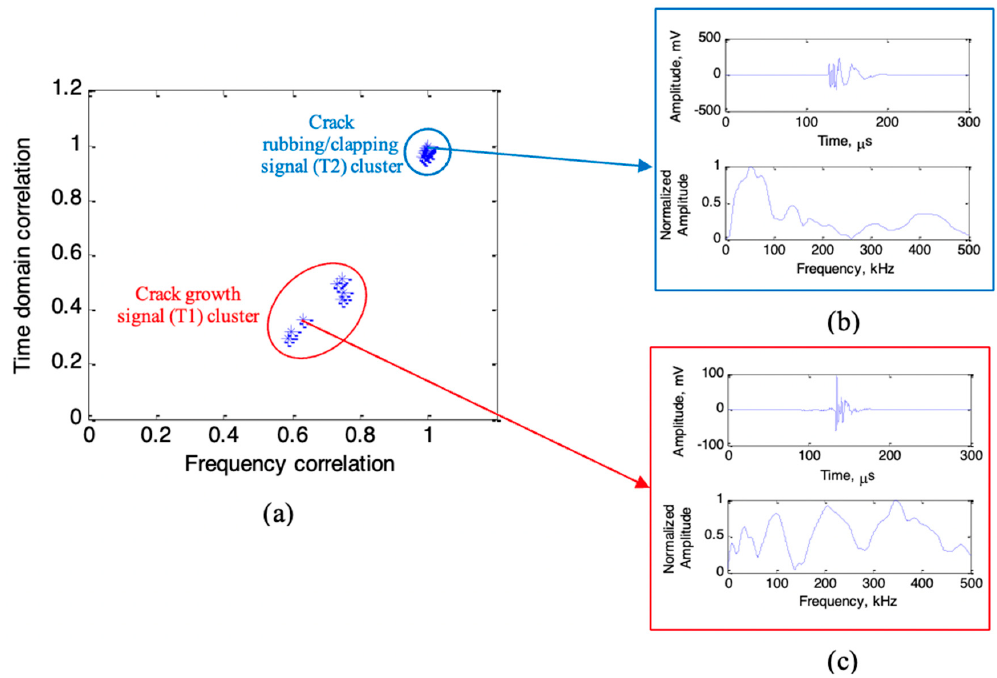
Figure 21. Clustering of fatigue crack growth (T1) and fatigue crack rubbing/clapping (T2) AE signals during fatigue experiment using the Pearson correlation method. ( a ) Pearson correlation plot; ( b ) representative signal from T2 cluster; ( c ) representative signal from the T1 cluster.